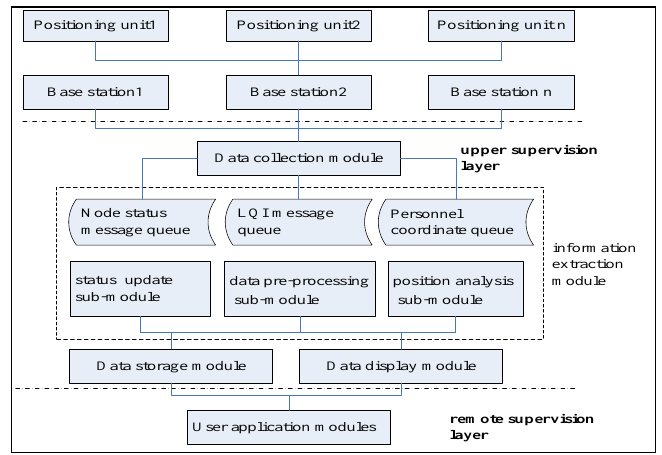
Figure 11. Software structure of the MPPS.